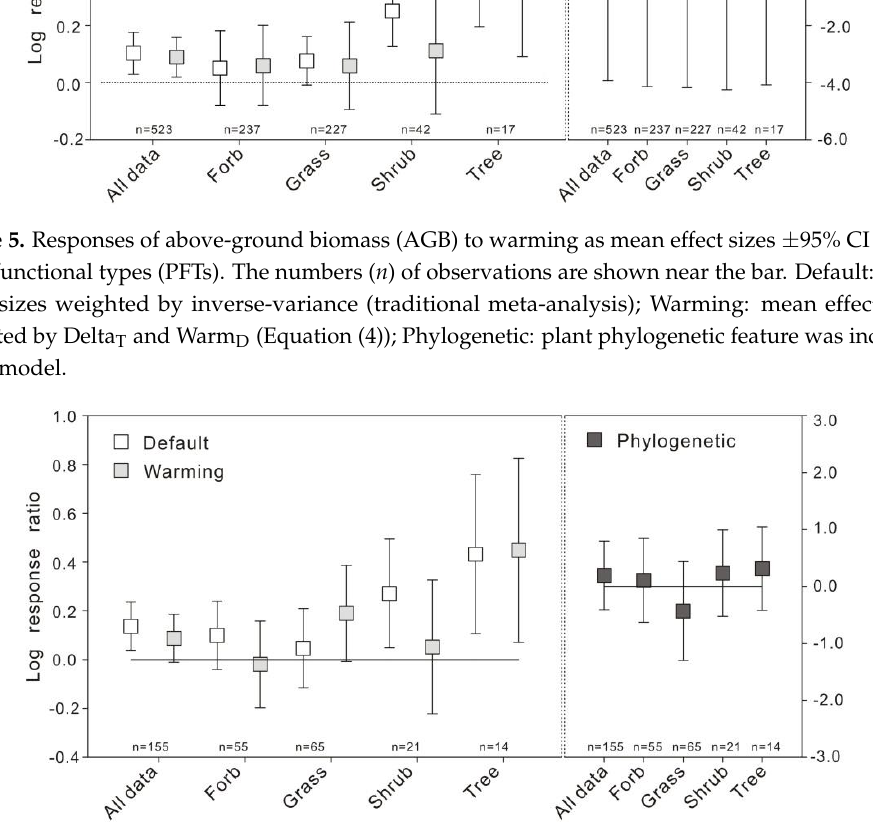
Figure 6. Responses of below-ground biomass (BGB) to warming as mean effect sizes ± 95% CI across plant functional types (PFTs). The numbers ( n ) of observations are shown near the bar. Default: mean effect sizes weighted by inverse-variance (traditional meta-analysis); Warming: mean effect sizes weighted by Delta T and Warm D (Equation (4)); Phylogenetic: plant phylogenetic feature was included in the model.